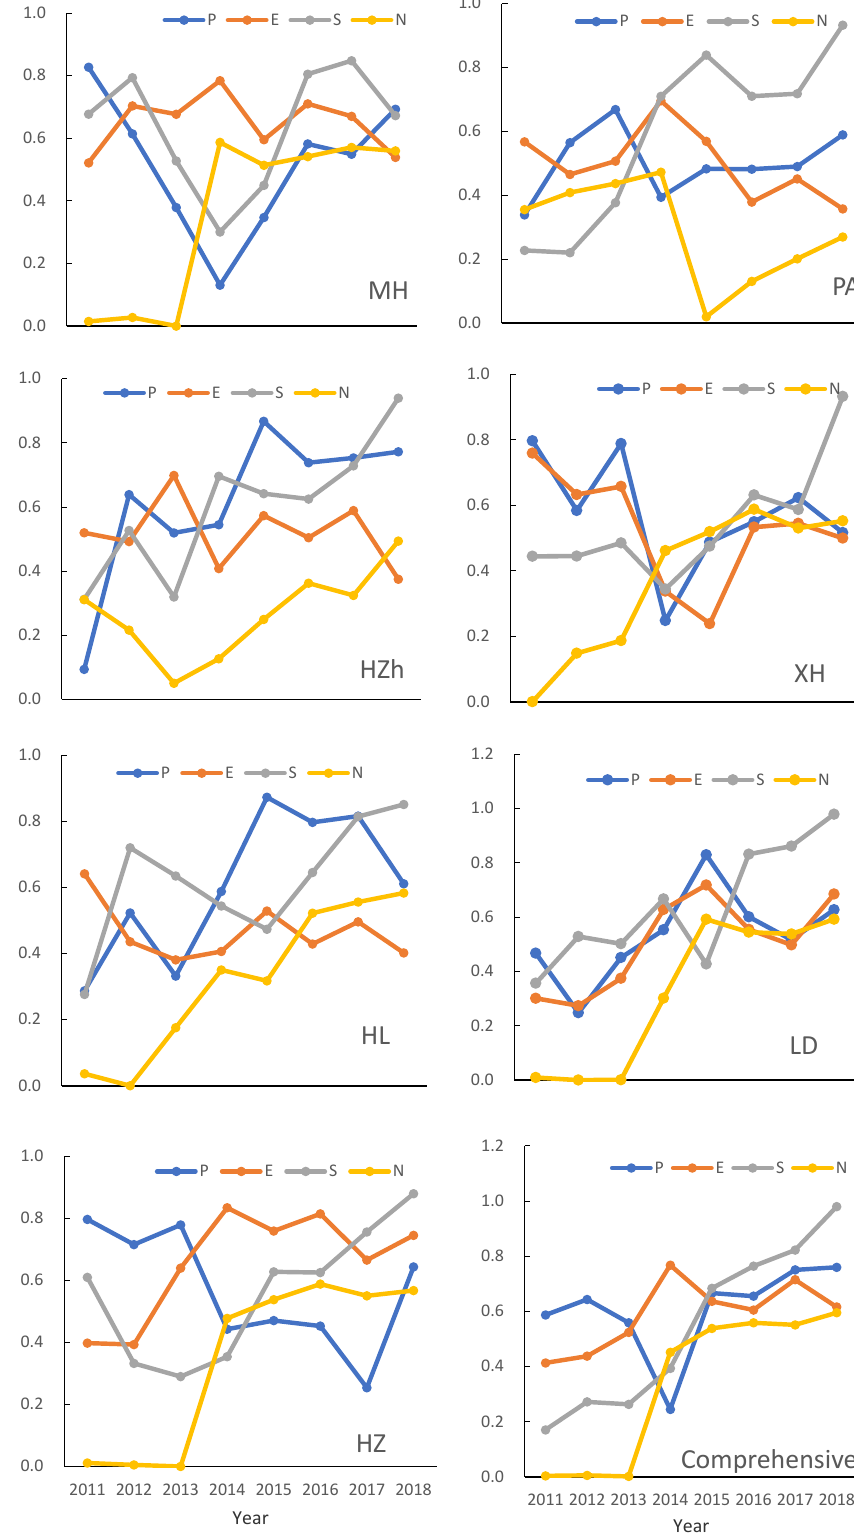
Figure 3. Changes in ecological security early-warning values of various districts and counties by target level and comprehensive value from 2011 to 2018. (The “comprehensive value” is calculated according to the process of 3.1 after averaging the index values of the seven districts and counties). From different regions, the early-warning values of XH and HZ have fluctuated greatly (Figure 3). HZh, HL, LD, HZ are all four stages, in which LD and HZ early-warning values rise to varying degrees after falling in 2011–2012, while HL and HZh show a broken line fluctuation rising state, and both reach the peak in 2015. This fluctuation is due to the dramatic changes in population, education and employment in these counties over the past eight years, and the population warning level is unstable. On the warning level of population, the relative law of MH is “V” shaped. From 2011 to 2014, it showed a straight-line downward trend, and then the fluctuation rose to 0.6727 in 2018. Indicating that the population, employment and education level changed significantly in the later period. However, PA has three stages (“rise fall rise” stage). After a rapid rise in 2011–2013, PA showed a straight-line decline in 2014, and then rose slowly in 2015. Although it is not as good as the above-mentioned counties in the change stage, there are also obvious fluctuations, large amplitude and unstable overall situation. In contrast, XH has five stages, with the most frequent fluctuations. The results show that the fluctuation of the population warning layer is obvious and the state is unstable, which is mainly related to population change, employment rate, education level and other factors. To sum up, it is necessary to increase human capital investment and strengthen the ability to get rich and self-development. We should vigorously develop vocational education, organize and carry out effective skills training, improve the cultural quality of farmers in mountainous areas and promote the employment rate.4.3.2 Dynamic changes in the ecological environment early-warning layer. In general, the change in the eco-environmental early-warning layer from 2011 to 2018 can be divided into three stages. In the first stage (the ascent stage), from 2011 to 2014, the early-warning value rose from 0.4133 to 0.7678. This indicates that the intensity of fertilizer application and natural disasters in the mountainous area of Qinghai province in the course of agricultural production have been weakened, and the pressure on the ecological environment has been alleviated to some extent. The second stage (decline stage), specifically, 2014–2016, decreased from 0.7678 to 0.6051, with a decrease rate of 21.19%. The main reason for this decline is that in recent years, the intensity of the use of chemical fertilizers and pesticides has increased remarkably, and the number of natural disasters has increased, leading to pressure on the ecological and environmental warning layer. In the third stage (the fluctuation stage), after a small recovery in 2017, the warning value dropped by 13.80% in 2017–2018. Over the past year, natural disasters and human disturbances have been the main reasons for the decline in the overall value of the ecological environment. This result shows that if it is necessary to ensure the stable and coordinated development of this layer, in addition to